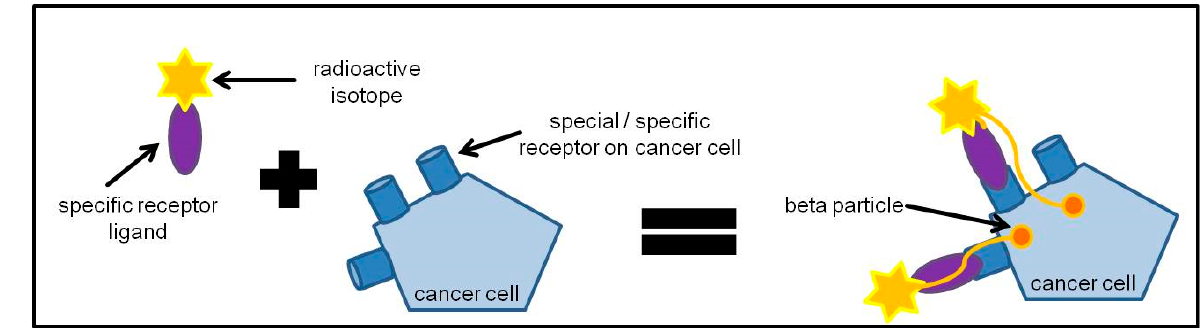
Figure 3. General principle of radioligand therapy. Cancer cells express special or sometimes specific receptors on their cell surface. Specific receptor ligands to these receptors can be labeled with a radioactive isotope that can emit beta particles. The specific receptor ligand binds to the receptors on the cancer cell and the beta particles come within close proximity to the cancer cell so that the cancer cell can be treated with beta particles and be killed.